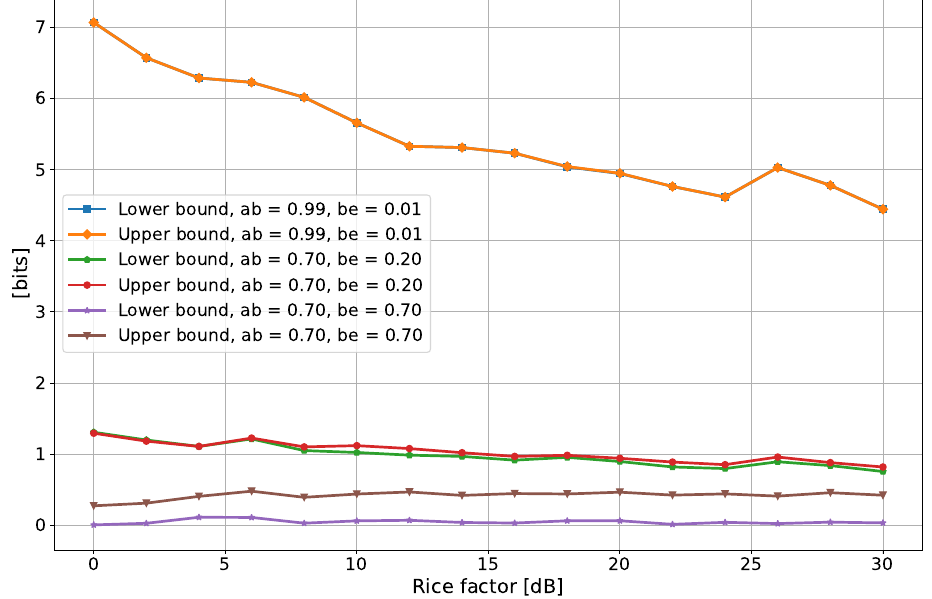
Figure 7. Secrecy key rate as a function of the Rice factor K, for different values of the correlation and with 4 filters. In the legend, “ab” and “be” stand for the Alice–Bob correlation and Bob–Eve